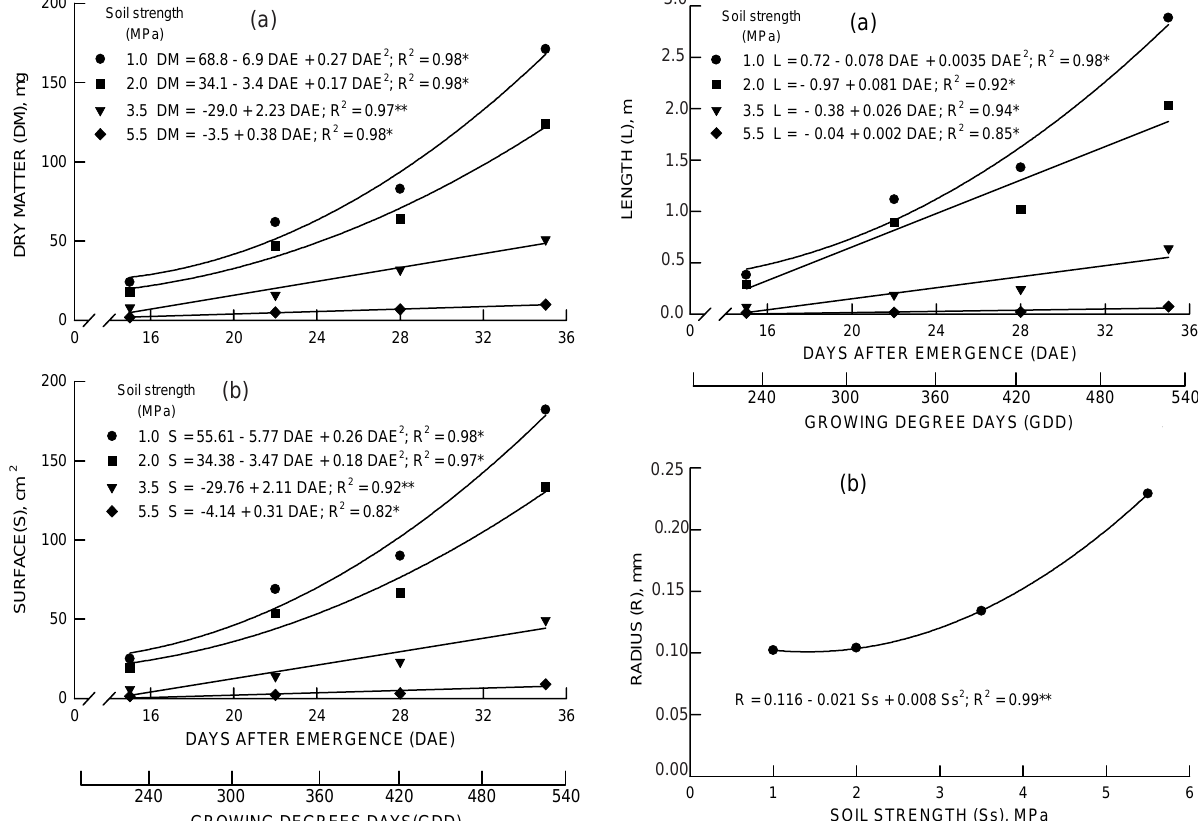
Figure 2. Wheat root length (a) and radius (b) under different soil